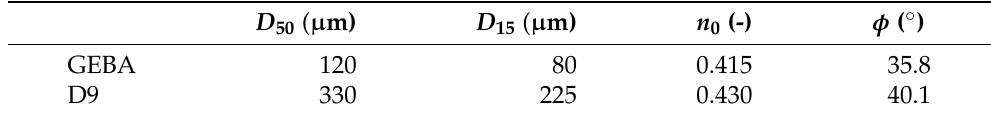
Table 1. Properties of the sands used in the